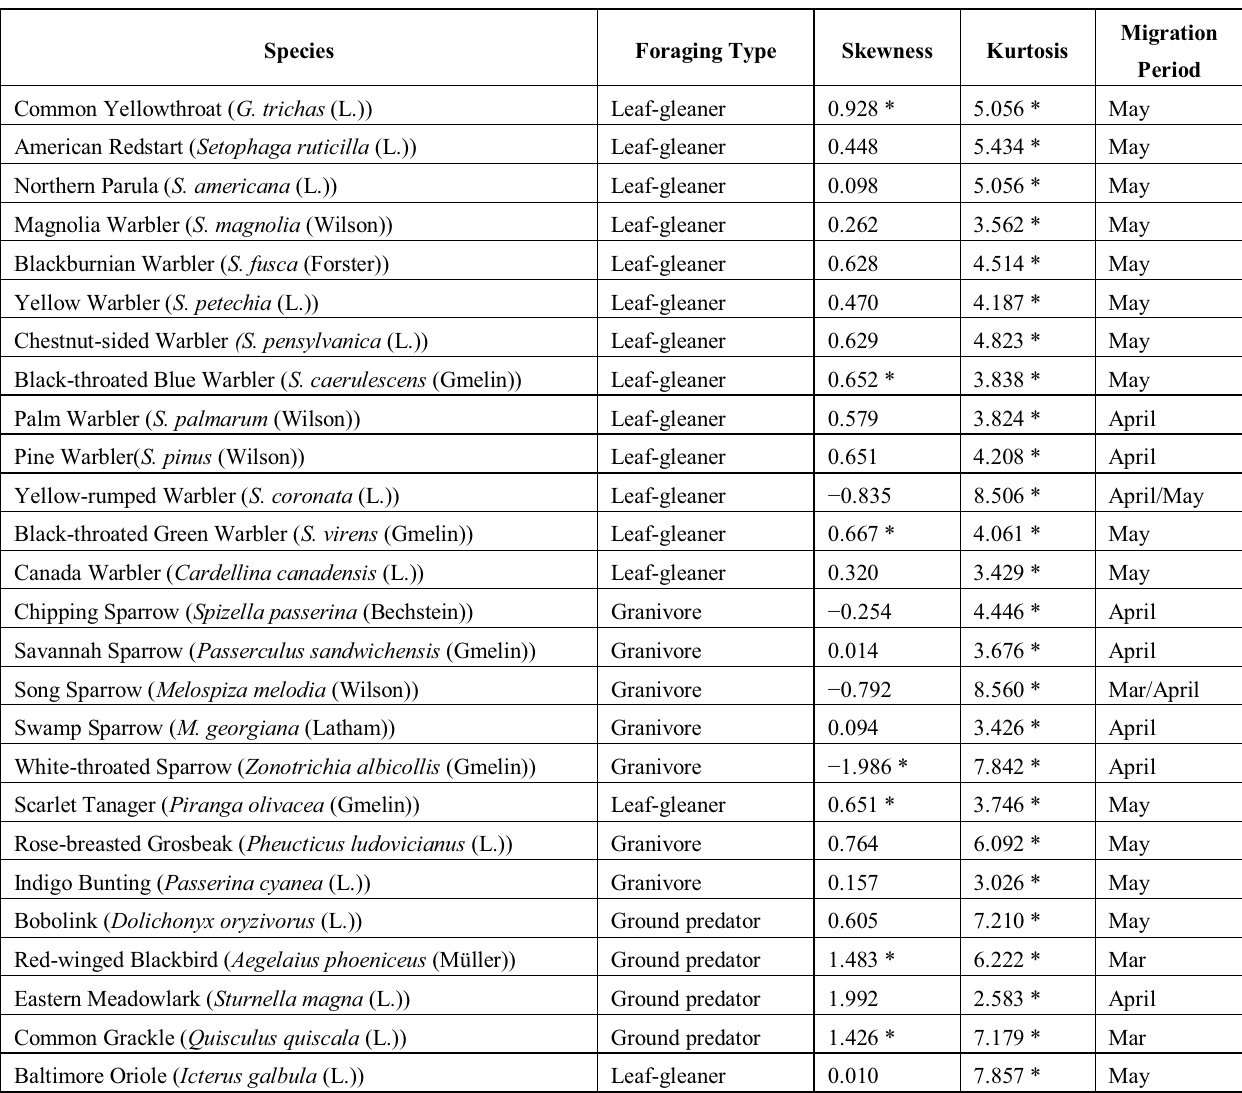
Table 1. Cont . Species Foraging